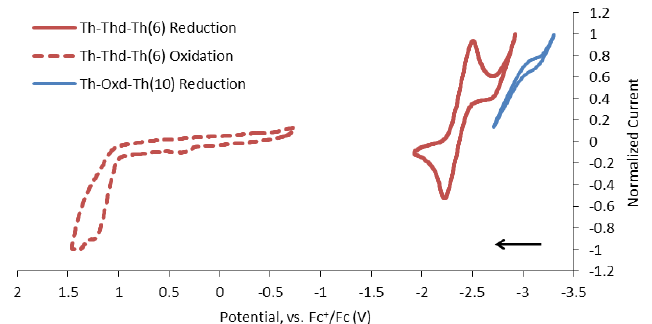
Figure 10. Cyclic voltammograms of 1.0 mM solutions showing reduction of Th-Thd-Th(6) (red) and Th-Oxd-Th(10) (blue) in THF with 0.1 M TBAP supporting electrolyte and oxidation of Th-Thd-Th(6) (red, dotted) in MeCN with 0.1 M TBAF supporting electrolyte.